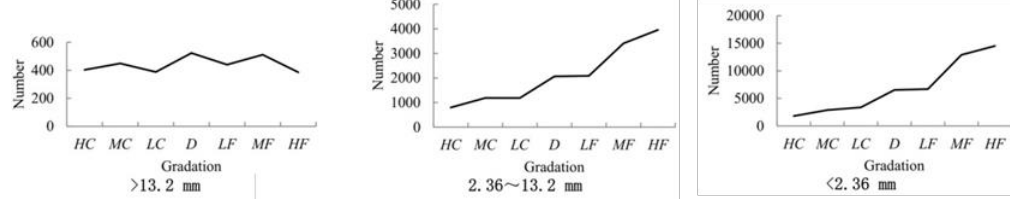
Figure 5. Change in the number of contact points.